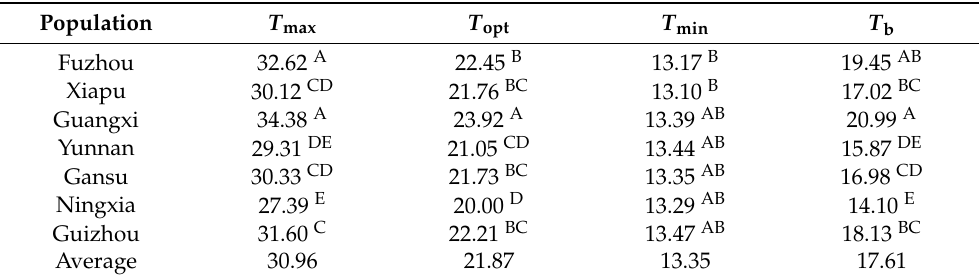
Table 2. Duncan’s multiple range test for differences in thermal preference among seven Phytophthora infestans populations derived from different temperature zones in China. The maximum ( T max ), optimum ( T opt ), minimum ( T min ) temperatures ( ◦ C), and temperature breadth ( T b ) of aggressiveness were estimated from the thermal reaction norm of each pathogen isolate.